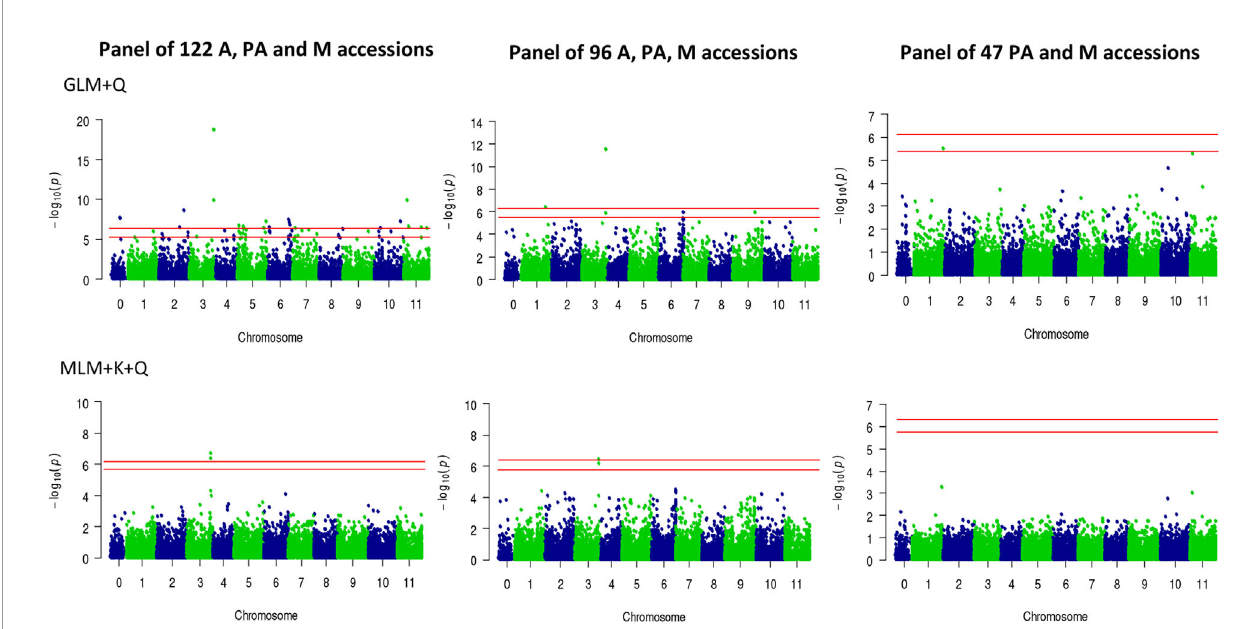
FIGURE 4 | Manhattan plots of GWAS in watermelon for andromonoecious index (AI). Two statistical models have been applied: GLM+Q (General linear model, corrected for population structure), and MLM+K+Q (Mixed linear model, corrected for both population structure and relatedness). The GWAS was performed using populations of differing sizes: 122 accessions, comprising the sex morphotypes A, PA, M; 96 accessions, comprising the morphotypes A, PA and M, and 47 accessions, comprising the morphotypes PA and M accessions. Red horizontal lines indicate the Bonferroni corrected signi fi cance thresholds of GWAS at p=0.05 and p=0.01,